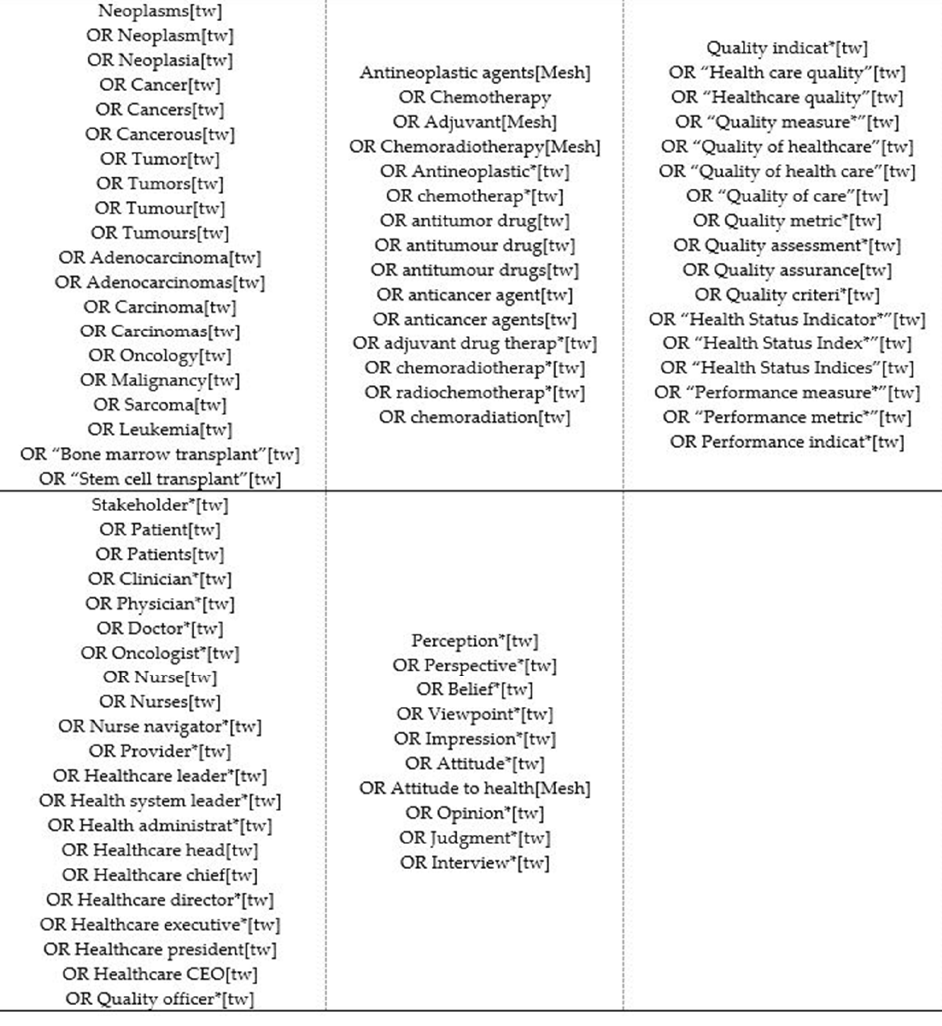
Figure 3. Search terms.